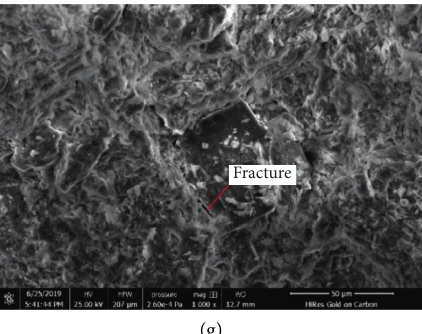
Figure 2: Scanning pictures of the local saline-alkali soil (enlarge 1000 times). (a) Surface soil. (b) Soil at depth 10 cm underground. (c) Soil at depth 20cm underground. (d) Soil at depth 30cm underground. (e) Soil at depth 40cm underground. (f) Soil at depth 50cm un- derground. (g) Soil at depth 60cm